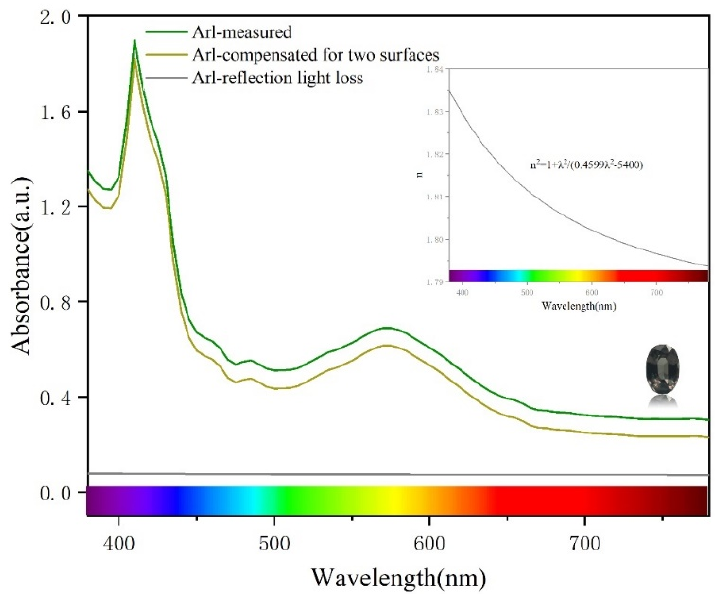
Figure 5. Corrected UV-Vis spectra of the colour-changing garnet sample B3, and relationship between refractive index and wavelength.